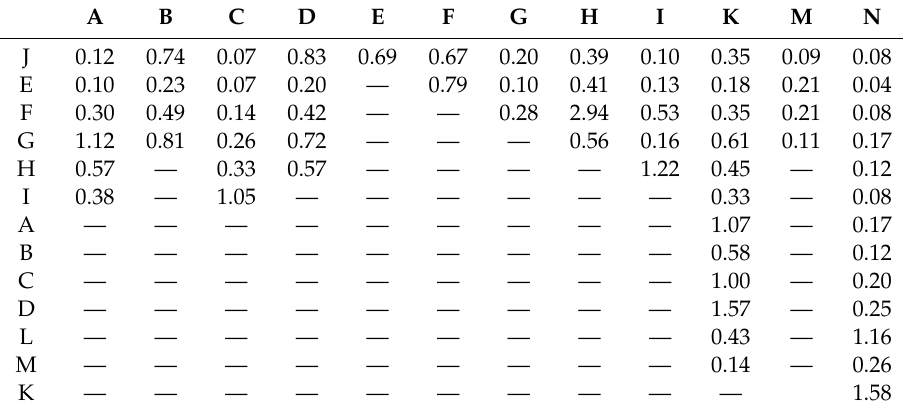
Note: rows indicate cause factors; columns indicate result events.